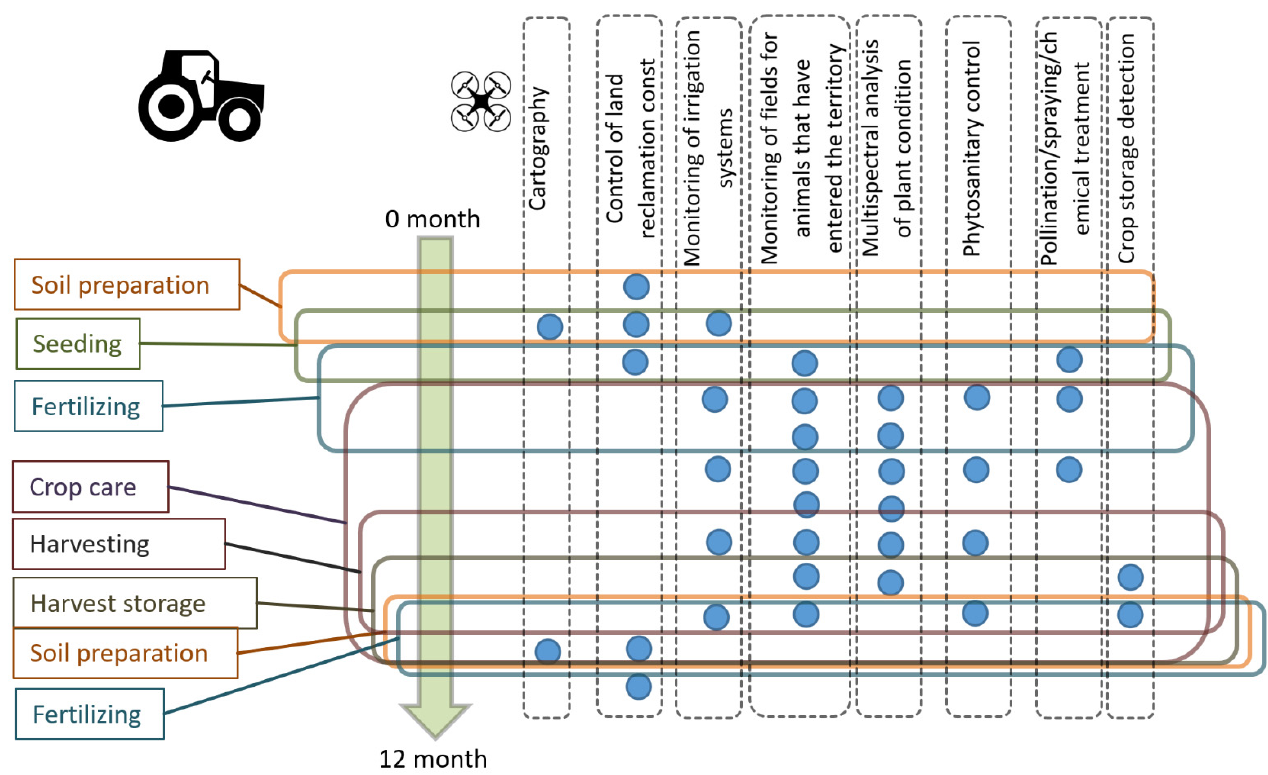
Figure 3. Periods of agrotechnical activities of precision farming and possible use of UAVs. Source: Generated by the authors.